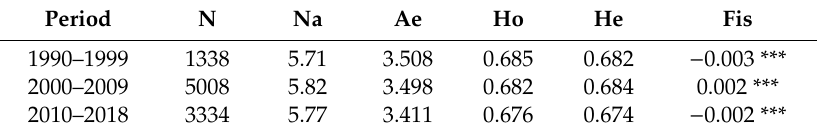
Table 3. The genetic parameters in the population of TB horses for 1990–2018. Period